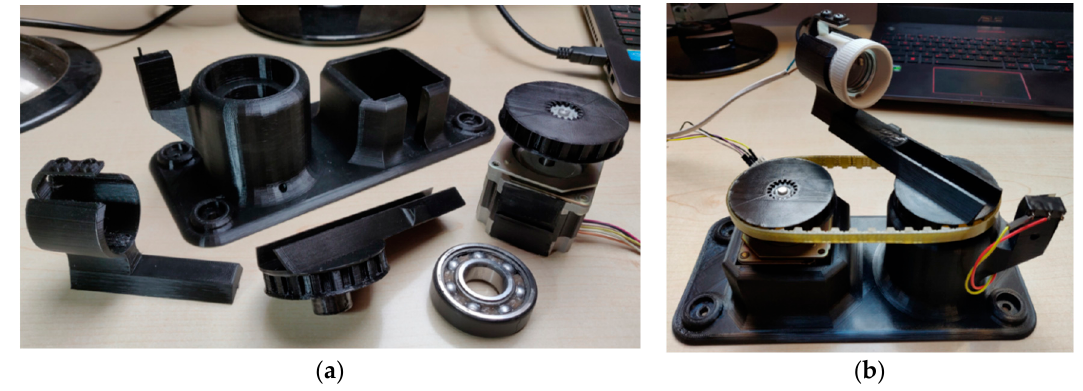
Figure 2. ( a ) Components of the rotary sliding table; ( b ) Assembled rotary sliding table.